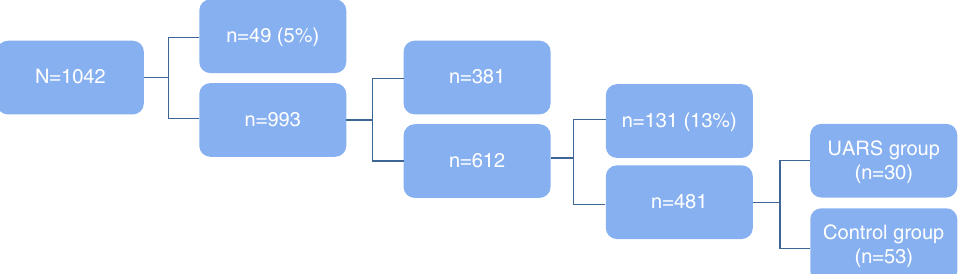
Project EPISONO 2007 flowchart with gradual exclusion of participants up to point when the only remaining participants were those who met the inclusion criteria.